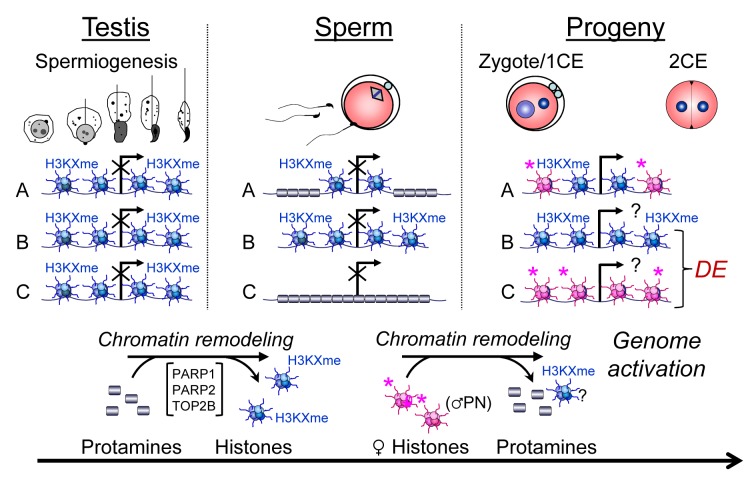
Chromatin remodeling events in spermiogenesis affect sperm histone-dependent regulation of gene expression during embryonic genome activation (working model).Chromatin remodeling during spermiogenesis (left panel) leads to the exchange of nucleosomes (blue) with their specific paternal tail modifications by protamines that normally leads to regulated retention of histones in certain domains of a given gene locus (A). Modulation of this remodeling process, for instance by altering PAR metabolism, results in either insufficient exchange of histones (B) or excessive remodeling causing more intense depletion of histones from that locus (C). As a result, histone association of this locus can be variable in sperm (middle panel). After fertilization, the paternal chromatin becomes rapidly remodeled, again with the exchange of protamines, but presumably not paternal histones, for maternally provided histones (pink) with maternal tail modifications that are mostly activating or nondescript in nature (right hand panel). As a result, the ratio of maternal and paternal histones can vary at the time point of genome activation, leading to continued differential epigenetic remodeling of the locus and ensuing differential expression (DE) in the early embryo.